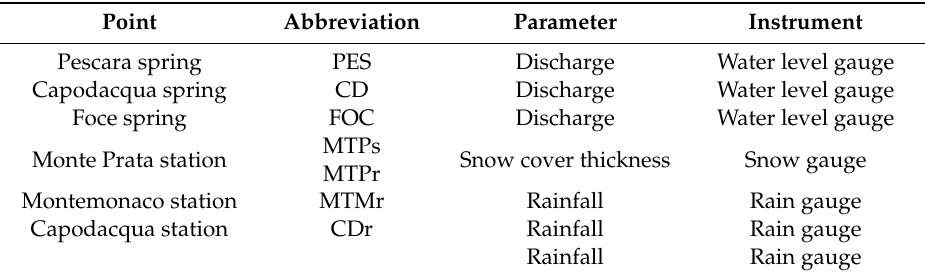
Table 1. Details of the points of the monitoring network considered in this